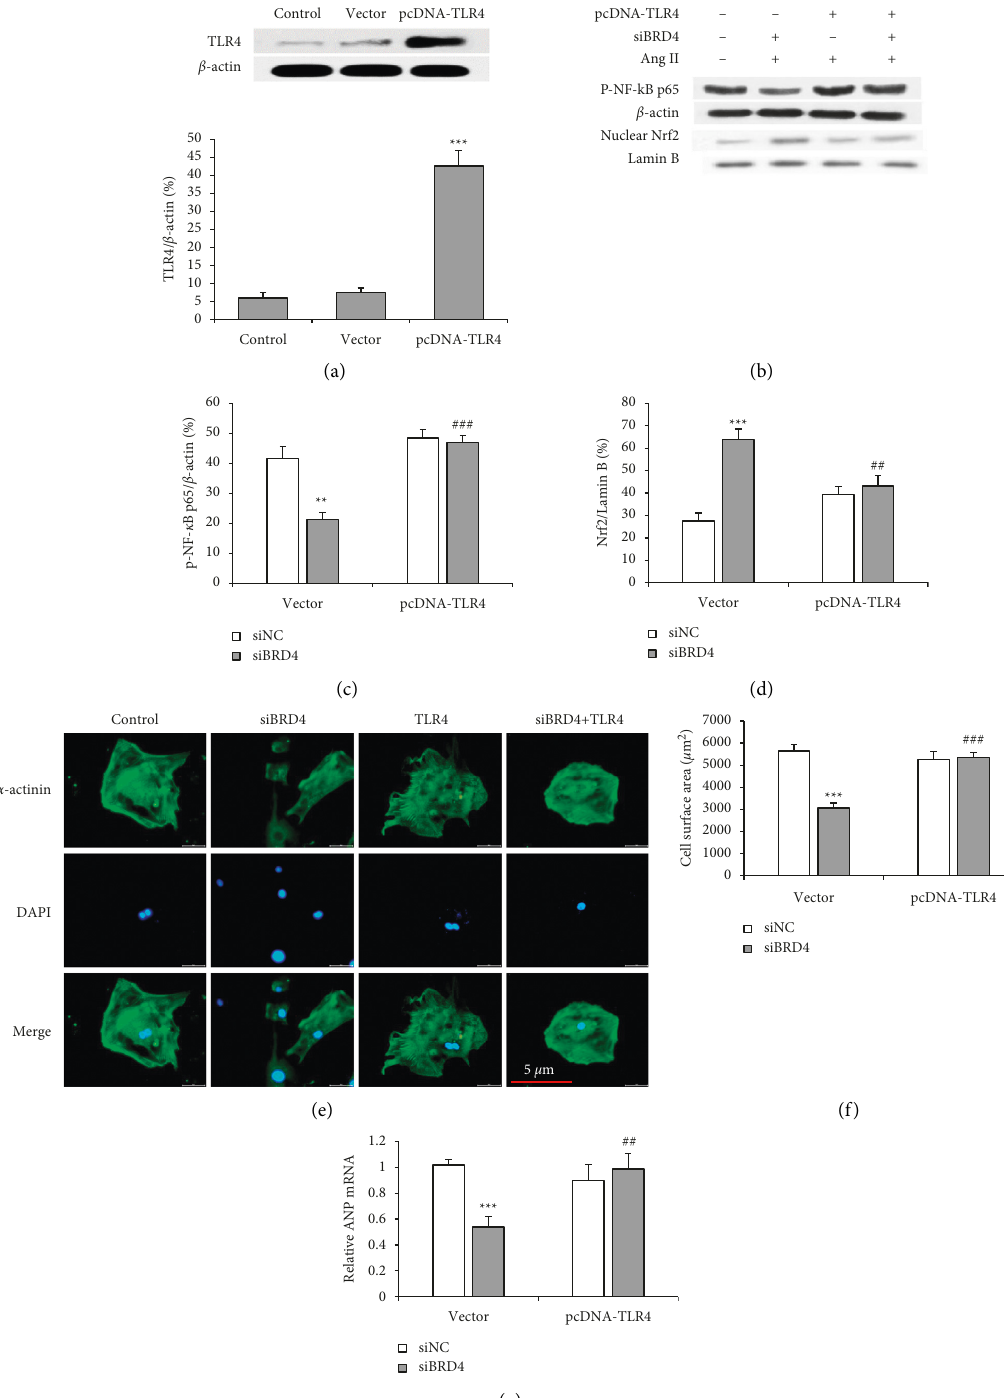
Figure 6: Overexpression of TLR4 reduces siBRD4-mediated protection against Ang II-induced cardiac hypertrophy. The induced Ang II cells were used as a control in the experiments. (a) A Western blot confirms the efficiency of TLR4 overexpression after 48 hours. ∗∗∗ P < 0 . 001 vs. control group. (b) H9c2 cells were co-transfected with BRD4-specific siRNA (siBRD4) and pcDNA-TLR4 or vector and then subjected to Ang II for 48 hours. A Western blot was performed to determine NF-kB p65 (b), (c) and nuclear Nrf2 (d) in H9c2 cells. Immunofluorescence was performed to evaluate the hypertrophic responses (e), and the cell surface area was compared (f). The mRNA expression of ANP was detected using a real-time PCR (g). Each experiment was performed in triplicate and repeated at least three times. ∗∗ P < 0 . 01, ∗∗∗ P < 0 . 001 vs. vector +siNC group; ## P < 0 . 01, ### P < 0 . 001 vs. vector +siBRD4